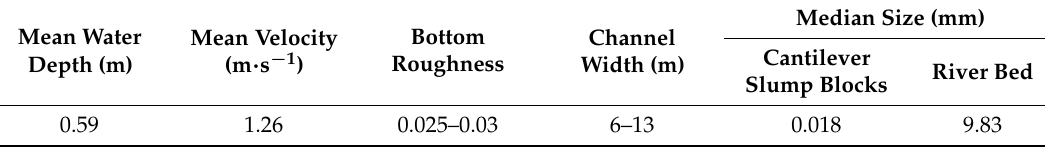
Table 3. Hydraulic parameters and morphological parameters of the study area.